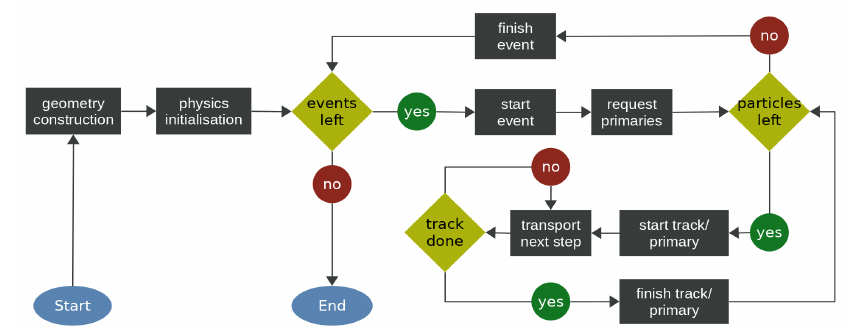
Figure 1. Sketch of the general VMC workflow. Boxes represent additional interaction between a VMCEngine and UserApp